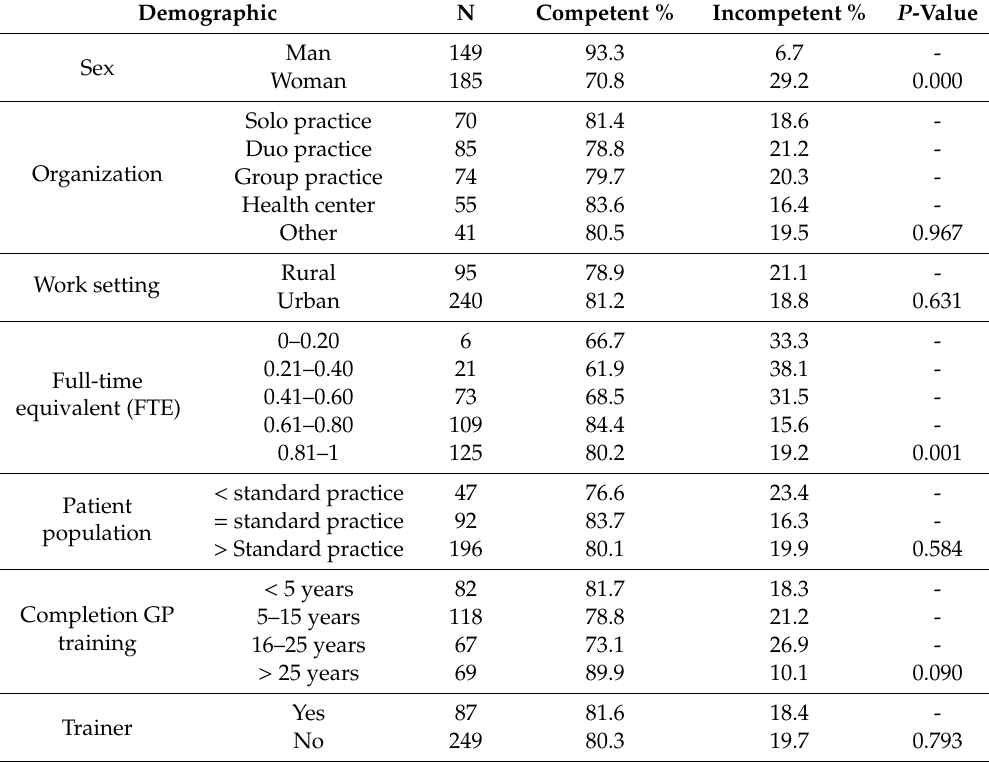
Table3. Percentagesofself-assessed(in)competentGPsinperforminginjectionsperdemographicgroup.